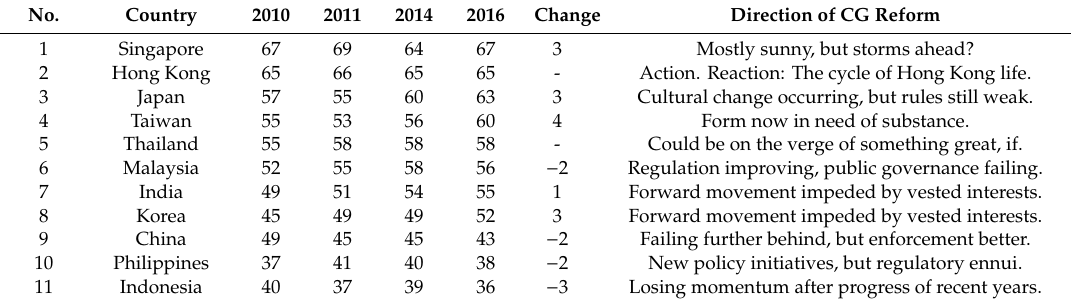
Table 1. Corporate governance (CG) watch market scores: